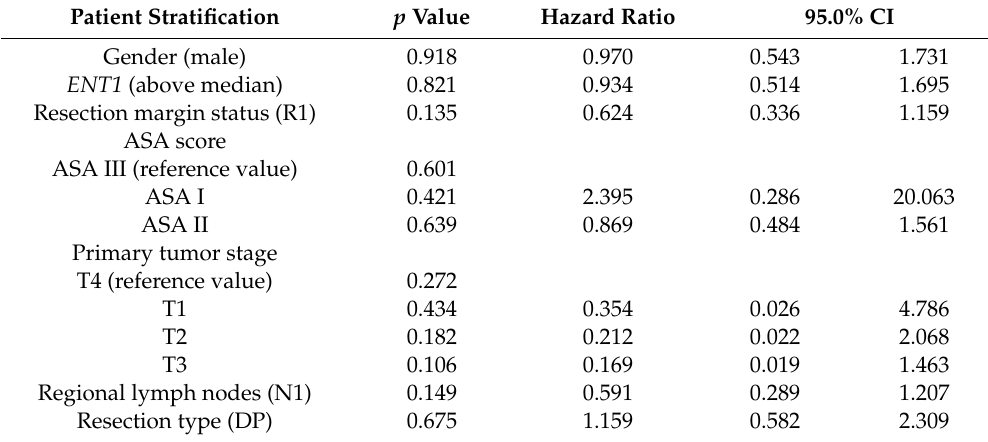
Table 2. Results of multivariate analysis (Cox’s proportional hazards model) of the e ff ects of clinical and pathological characteristics and ENT1 mRNA expression on patients’ DSS.